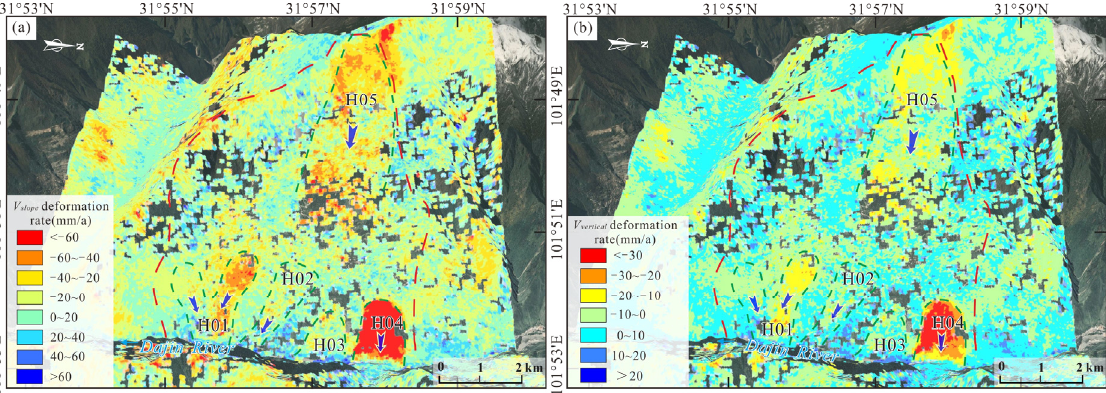
Figure 6. Two ‐ dimensional deformation rate of the Jiaju ancient landslide; ( a ) slope direction; ( b ) vertical direction. Table 3. The monitoring and identification results of the Jiaju ancient landslide based on InSAR.